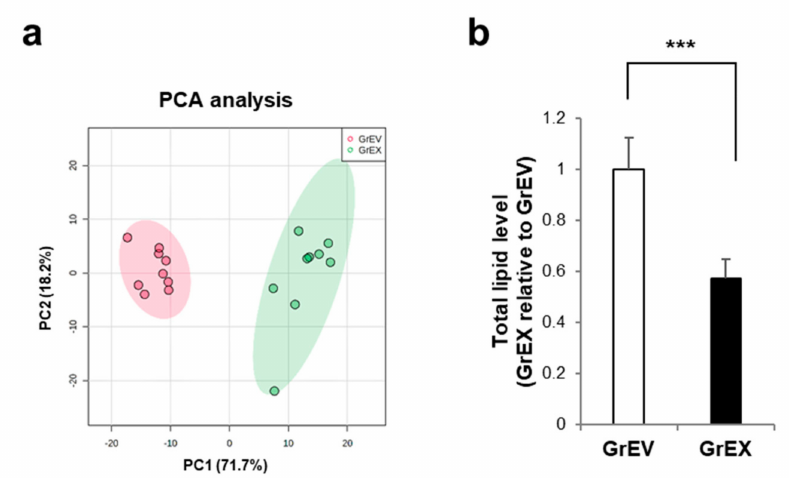
Figure 6. The discriminative lipidomic profile of ginseng root-derived extracellular vesicles (GrEVs). ( a ) Principal component analysis (PCA) of lipidomic information was performed based on the mass spectrometry (MS) data of GrEVs and ginseng root extracts (GrEXs). Lipidomic data were analyzed statically using the package in MetaboAnalyst (n = 9 per group; three biological replicates, each with three technical replicates). X axis: principal component 1 (PC1). Y axis: principal component 2 (PC2). ( b ) Relative total lipid expression levels in both groups. The expression levels of total lipids were determined by summing the amounts of identified lipid species in GrEVs and ginseng root extracts (GrEXs), respectively. The value of fold change is shown as the means ± standard deviations (n = 9 per group; three biological replicates, each with three technical replicates). Statistical significance was analyzed by Student’s t -tests for two groups (*** p <